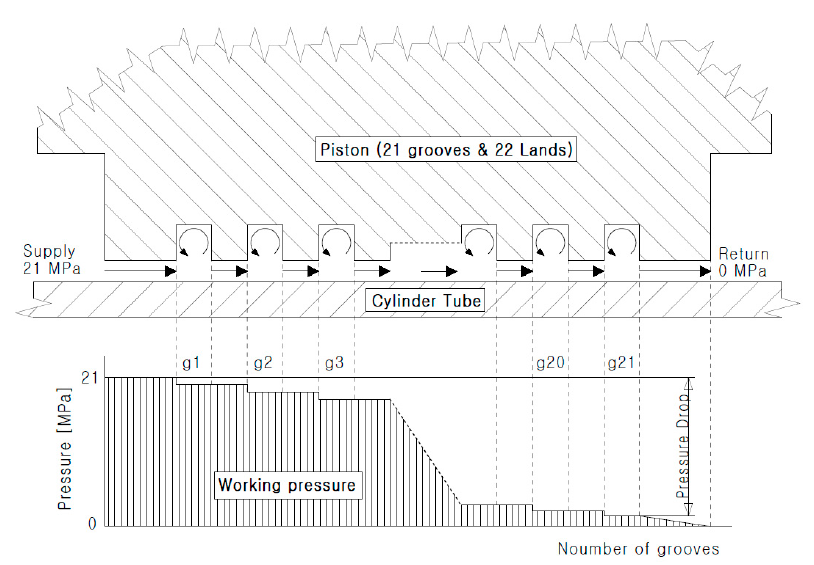
Figure 10. Pressure drop of the fluid flow through 21 radial grooves.